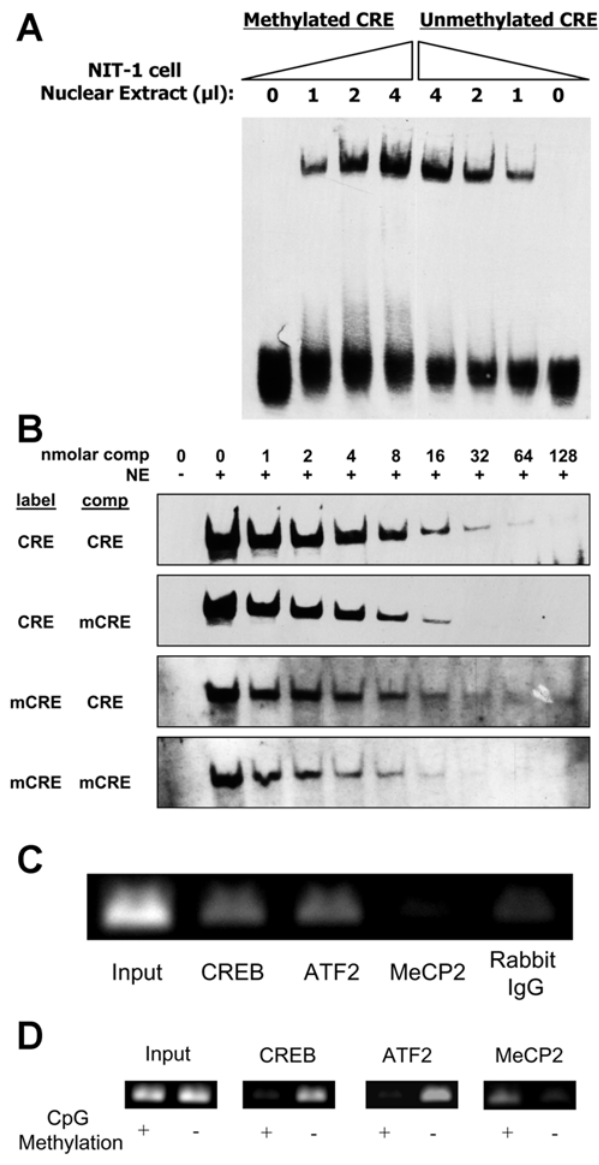
Figure 3. Effect of methylation on transcription factor binding to the Ins2 promoter. (A) Increasing amounts of NIT-1 nuclear extract was bound to methylated or unmethylated mouse Ins2 promoter CRE oligonucleotide in an Electrophoretic Mobility Shift Assay (EMSA). There was a dose-dependent increase in binding to both the methylated and unmethylated CRE with increasing amounts of NIT-1 cell nuclear extract. (B) The binding of NIT-1 nuclear proteins to one nanomolar of either labeled methylated (mCRE) or unmethylated (CRE) was competed with increasing concentrations of unlabeled CRE or mCRE. The figure is one representative of four experiments. (C) Chromatin immunoprecipitation (ChIP) analysis of the endogenous mouse Ins2 gene promoter in NIT-1 cells. Genomic DNA was immunoprecipitated with anti-CREB, anti-ATF2, anti-MECP2, and control IgG. The results indicate that CREB and ATF2, but not MeCP2, are normally associated with the endogenous insulin promoter. (D) Methylated or mock-methylated pGL4.10 Ins2 500bp (Fig. 2A) was transfected into NIT-1 cells and then ChIP was carried out with anti-CREB, anti-ATF2, and anti-MeCP2 antibodies. Methylation of the Ins2 promoter decreases the binding of CREB and ATF2, but increases the binding of MeCP2.